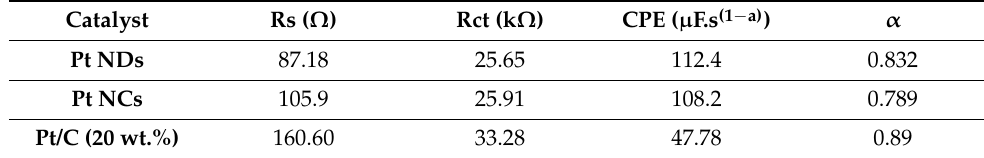
Figure 7. CVs in ( a ) N 2 -staruraed 0.5 M NaHCO 3 , ( b ) in CO-saturated 0.5 M NaHCO 3 at 50 mV/s on Pt NDs, Pt NCs, and Pt/C. CV curves at different scan rates and its related plots of j vs. v 1/2 on ( c , d ) Pt NDs, ( e , f ) Pt NCs, and ( g , h ) Pt/C in CO-saturated 0.1 M KOH. Table 3. Analysis of EIS measured in 0.5 M NaHCO 3 .